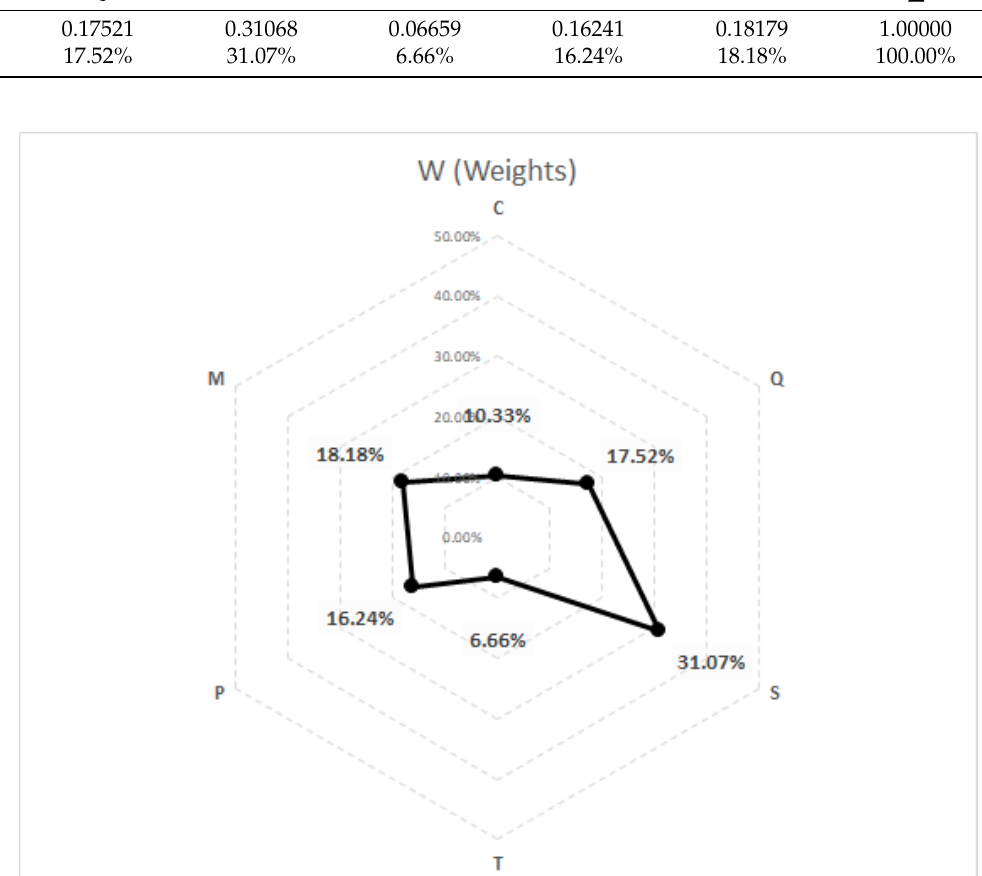
Figure 4. Radar distribution of the weights of the criteria in the aggregate matrix.